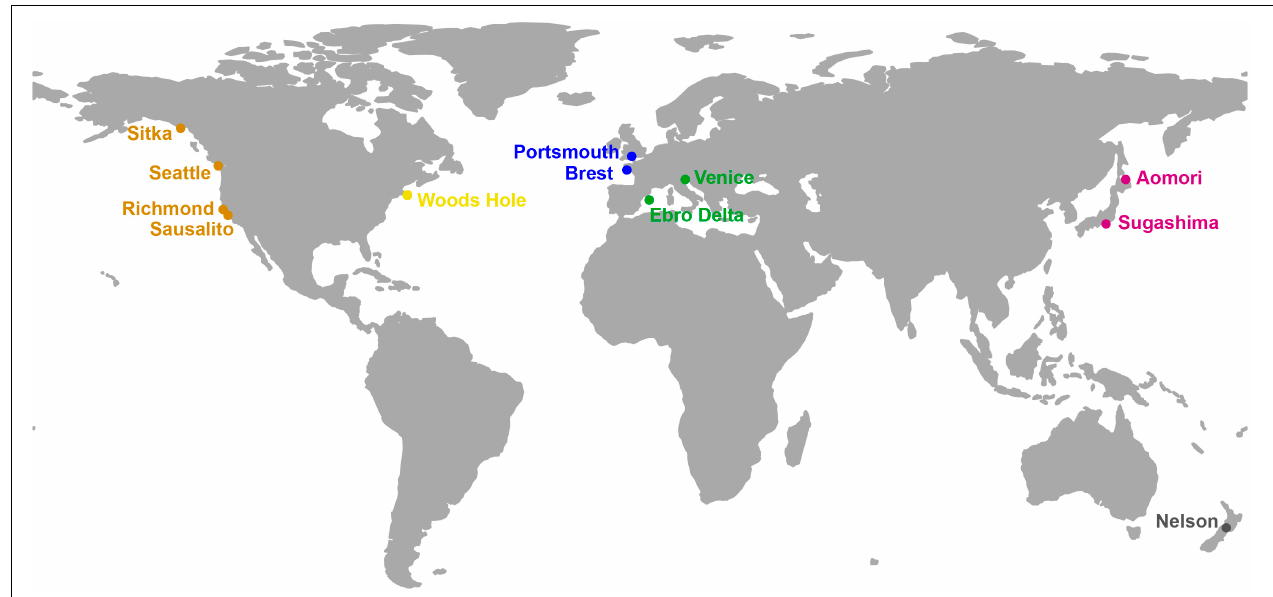
FIGURE 1 | Map of the localities sampled in the present study. Colors follow the palette used in the nmMDS plots. The map has been drawn with the R package “rworldmap (https://cran.rproject.org/web/packages/rworldmap/index.html).”